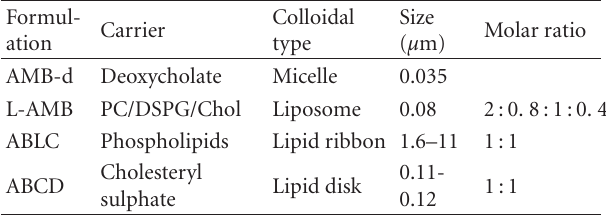
PC: phosphatidylcholine; DSPG: distearoylphosphatidylglycerol; Chol: